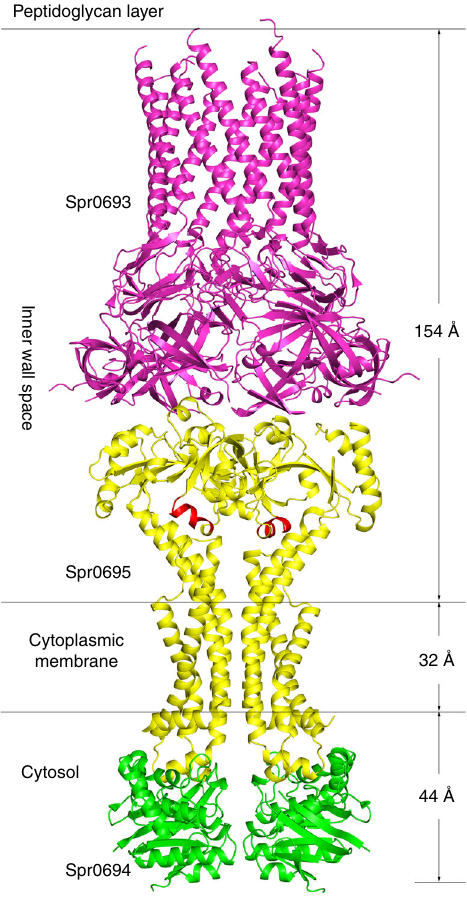
Fig. 5 The Spr0693 – 0694 – 0695 assembly. A simulated model